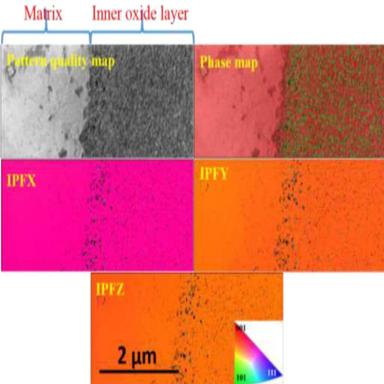
(a) TKD analysis (step size = 10 nm) on TEM sample 1 showing the pattern quality map (top left), phase map (austenite phase in red and spinel oxide phase in green, top right), IPFX map (middle left), IPFY (middle right), and IPFZ (bottom); (b) TKD analysis on TEM sample 2 (step size = 3 nm) showing the phase map (austenite phase in red and spinel phase in green, top left), IPFX map (top right), IPFY (bottom left), and IPFZ (bottom right).